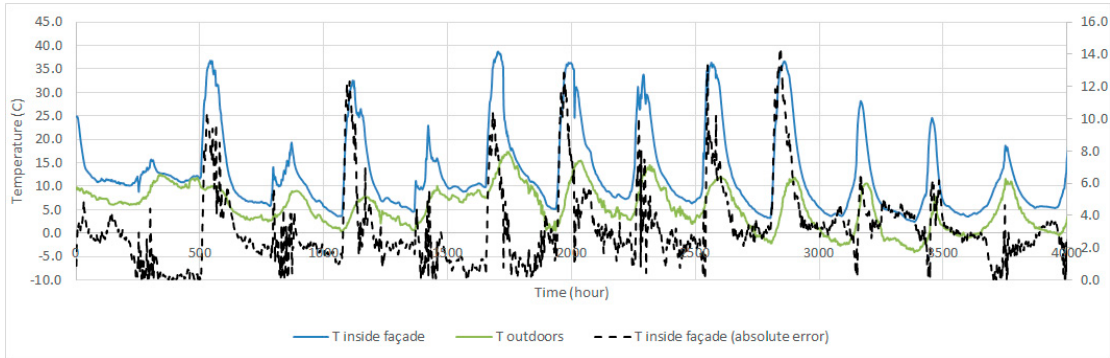
Figure 3. Absolute error of the predicted temperature inside the façade in comparison to the measured